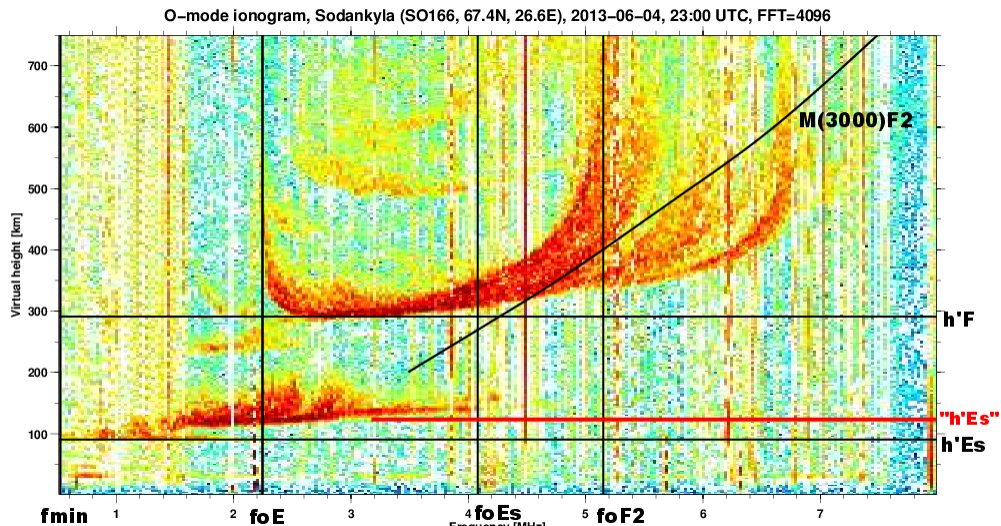
Figure 9. Differences between manual and Autoscala scaling arising from high latitude sporadic E phenomena. Black lines show manually scaled parameters, and red colour (lines and/or letter) indicates Autoscala results. Example 4: Error in h (cid:48) E s scaling (117km vs. manual